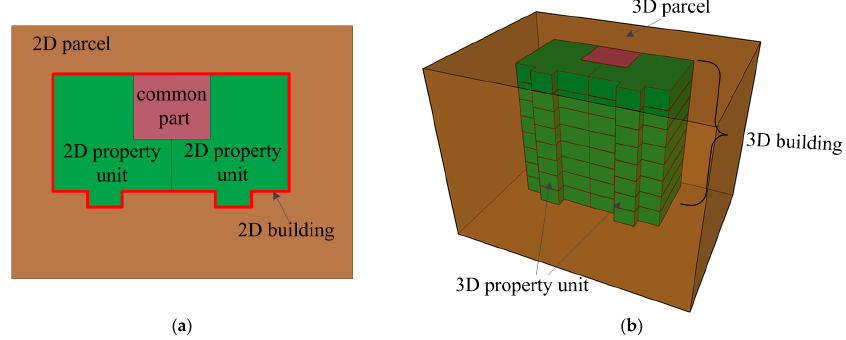
Figure 5. Representations of 2D spatial units ( a ) and 3D spatial units ( b ) for the same cadastral